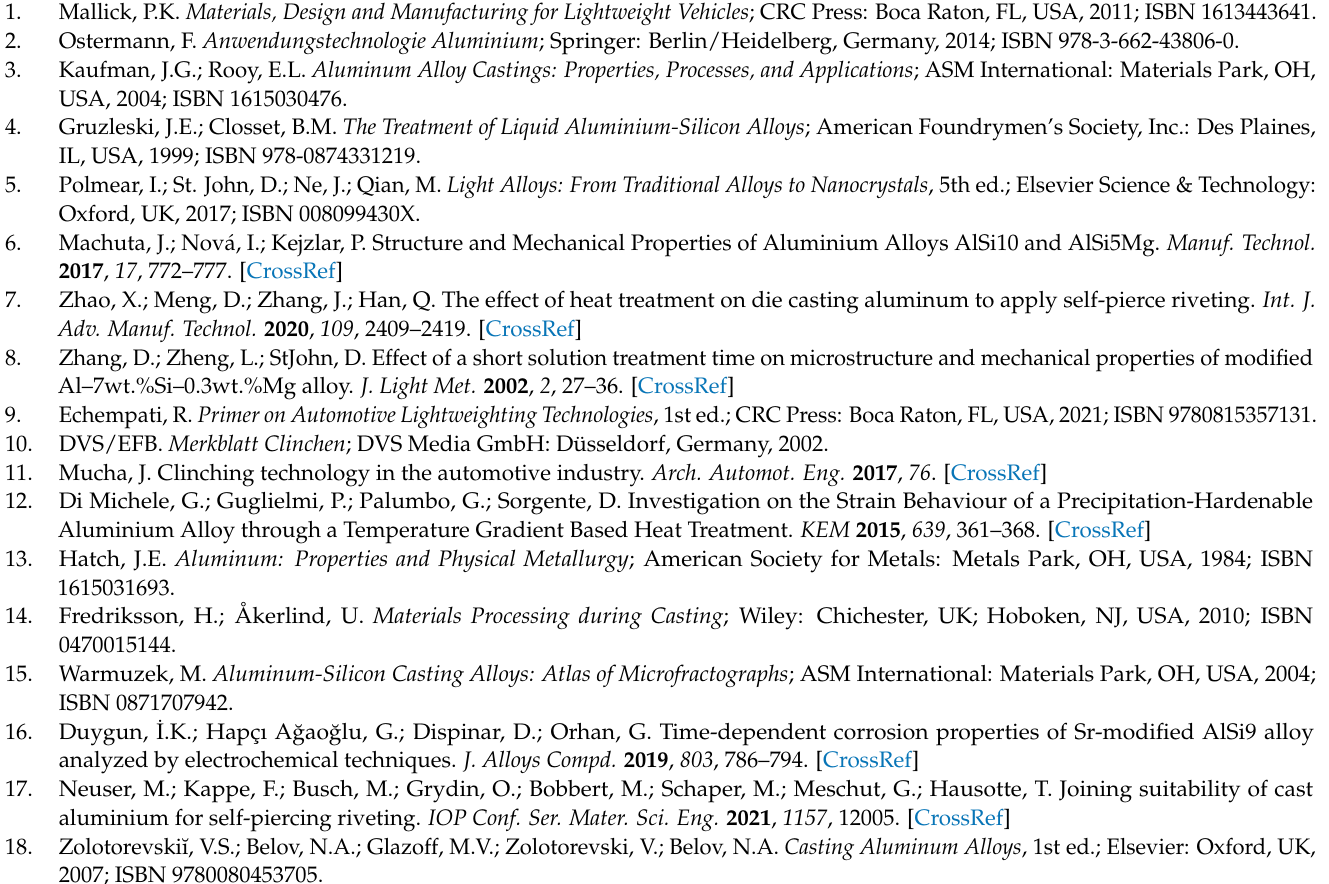
Figure S2: LOM-image of AlSi9 with a thickness of 2.5 mm. Figure S3: LOM-image of AlSi9 with a thickness of 3.0 mm. Figure S4: LOM-image of AlSi9 with a thickness of 3.5 mm. Figure S5: LOM-image of AlSi9 with a thickness of 4.0